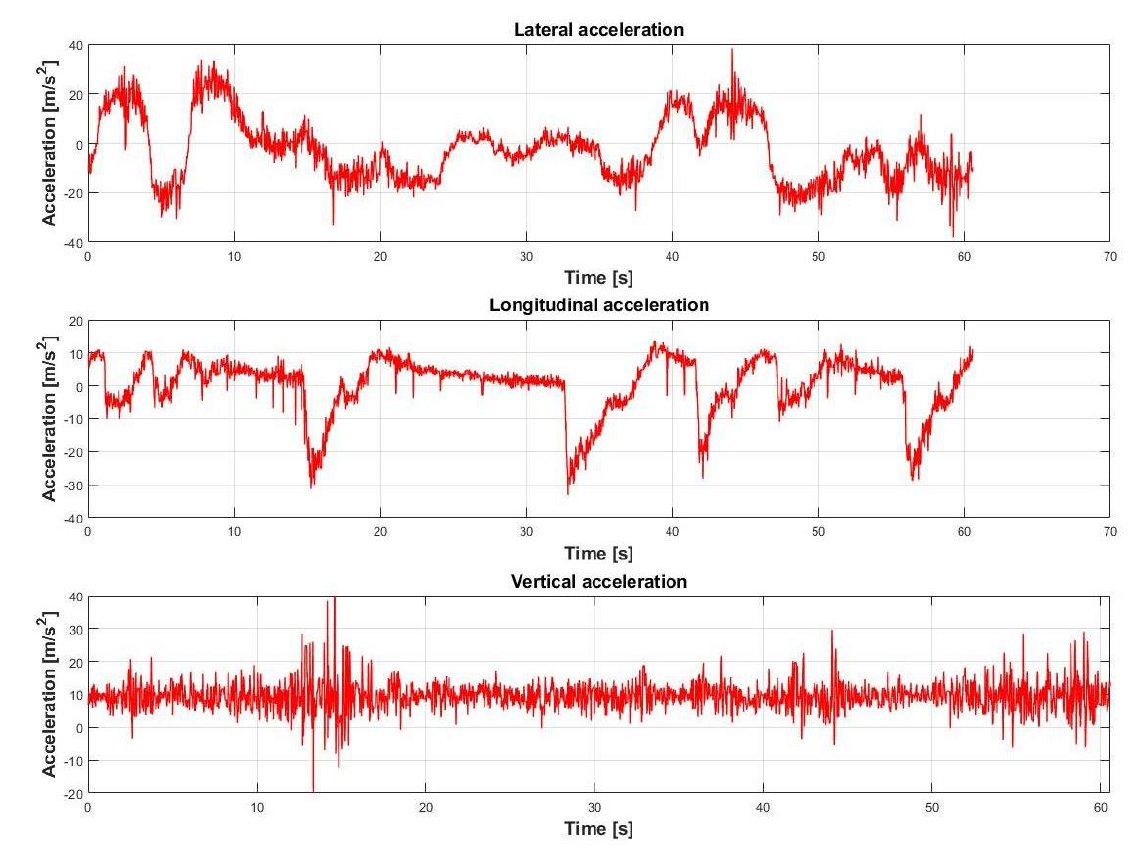
Figure 11. Lateral, longitudinal and vertical acceleration vs. time.